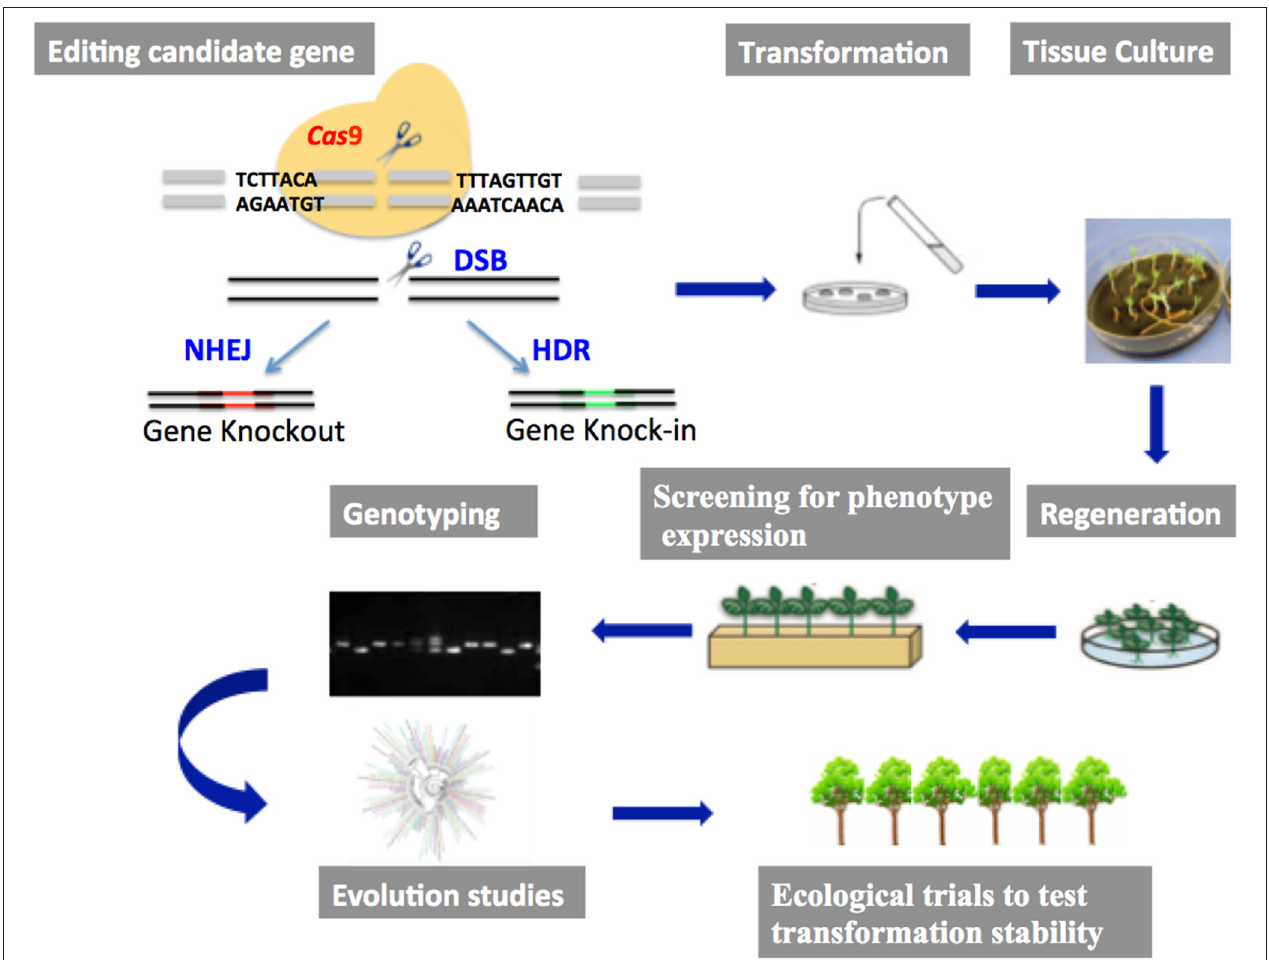
FIGURE 1 | Pipeline for gene editing using CRISPR/Cas9, showing the essential steps in the gene editing approach to landscape genomics and evolutionary